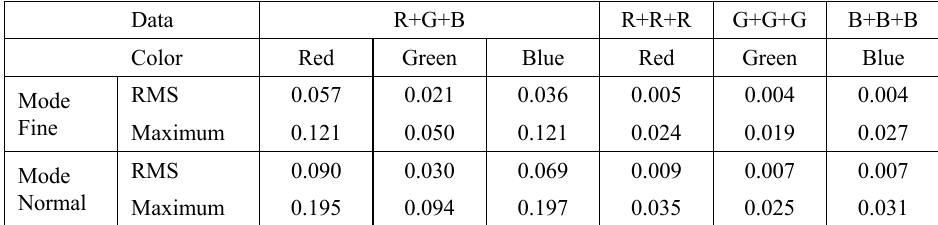
Table 3. RMS and maximum of displacements caused by lossy JPEG compression of 3600 evaluation points (unit: pixel)